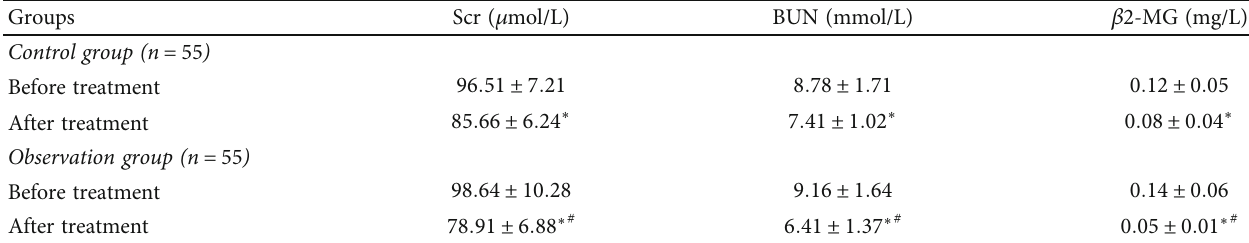
Table 3: Levels of renal function indices tested before and after treatment in both groups.